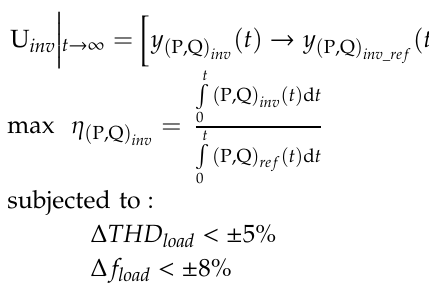
Figure 4. Control of the battery.